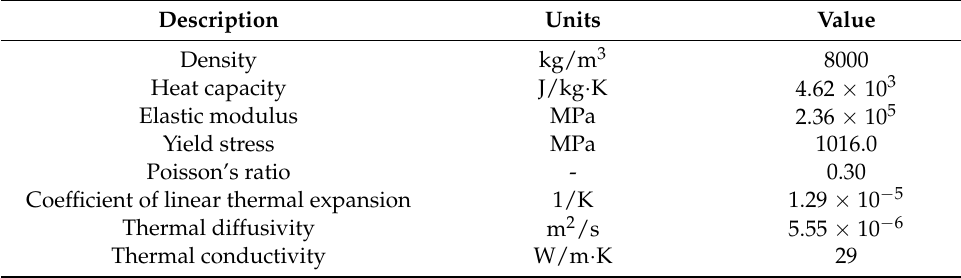
Table 3. Thermal, physical, and mechanical properties of steel alloy 1.2709. Description